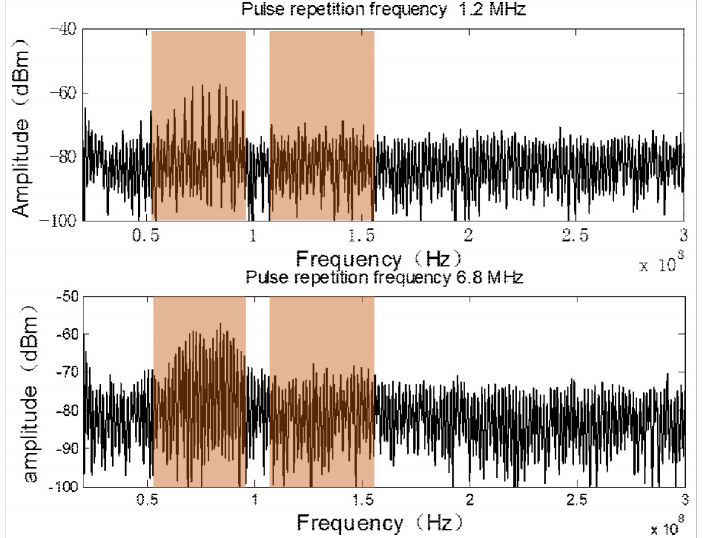
Figure 5. Frequency spectrum of discharge radiation signal at different pulse repetition frequencies.